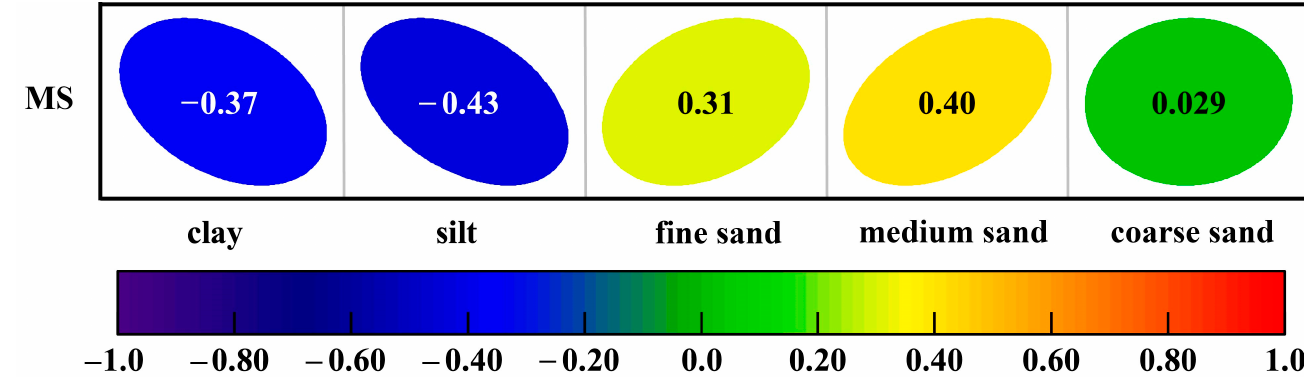
Figure 5. Correlation coe ffi cients between di ff erent grain size and